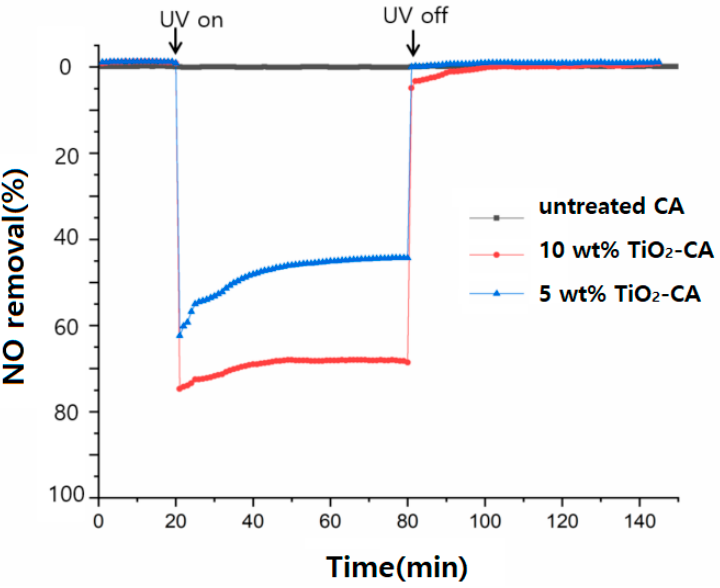
Figure 4. The photocatalytic effect of TiO 2 -CA nanofibers for NO gas